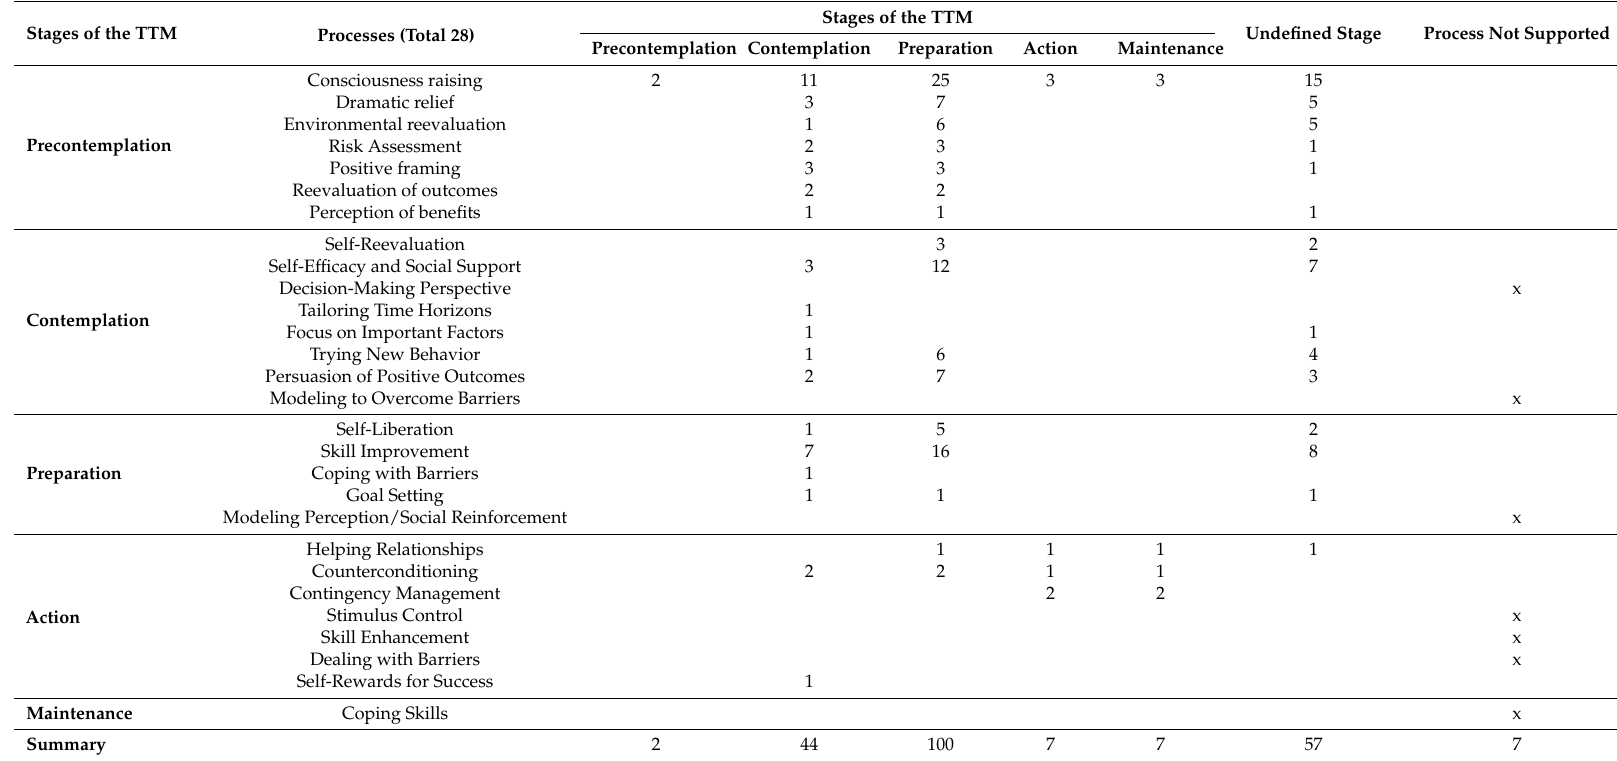
Table 4. Frequency of interventions supporting specific processes and stages of